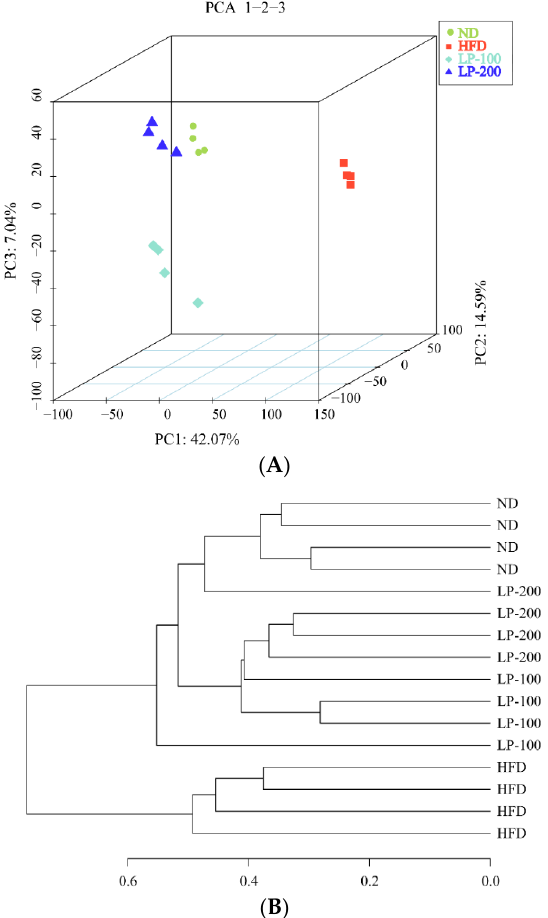
Figure 6. PCOA (3D) illustration of the non-weighted UniFrac-based principal coordinate analysis of the flora in the digestive tract ( A ). Diagram showing the gut flora based on Jaccard-based UPGMA analysis ( B ).